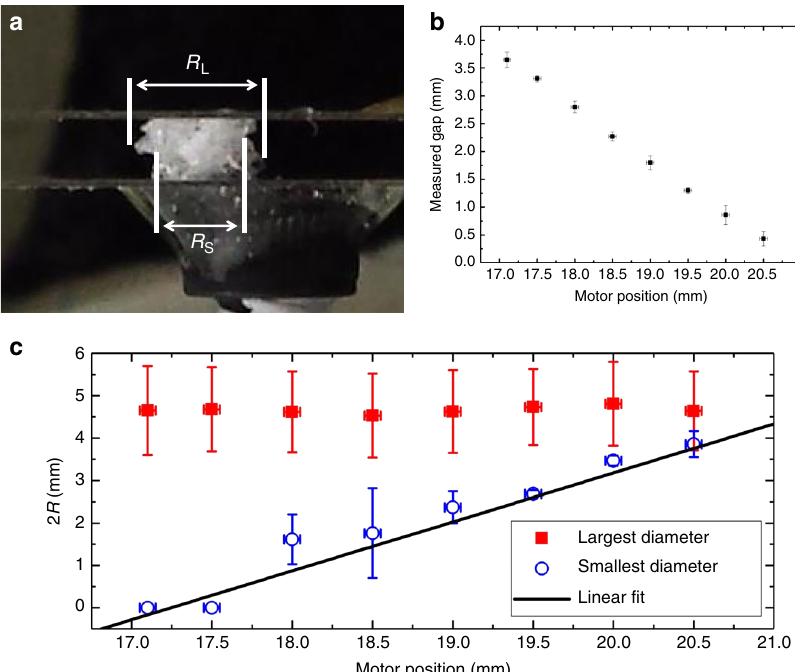
Fig. 8 The horizontal extent of a crumple during compaction. a A typical image of the horizontal extent of a crumple. In this case, a polycarbonate fi lm of diameter 4.7 mm is shown. R L and R S refer to the largest radius and smallest radius observed in the image. b Plate separation as a function of motor position showing a linear trend indicating that the apparatus is still stiff compared to the crumpled fi lm. Error bars determined from the standard deviation of multiple measurements (Measured Gap) or motor step size (Motor Position). c Change in the largest (solid squares) and smallest diameter (open circles) as a function of compression. The larger diameter does not change during the experiment; however, the smaller diameter does grow in an approximately linear manner (a slope of 1.15 was found with a linear fi t shown as the solid line). Error bars are the standard deviation of multiple measurements from two orthogonal images (Radius) or motor step size (Motor